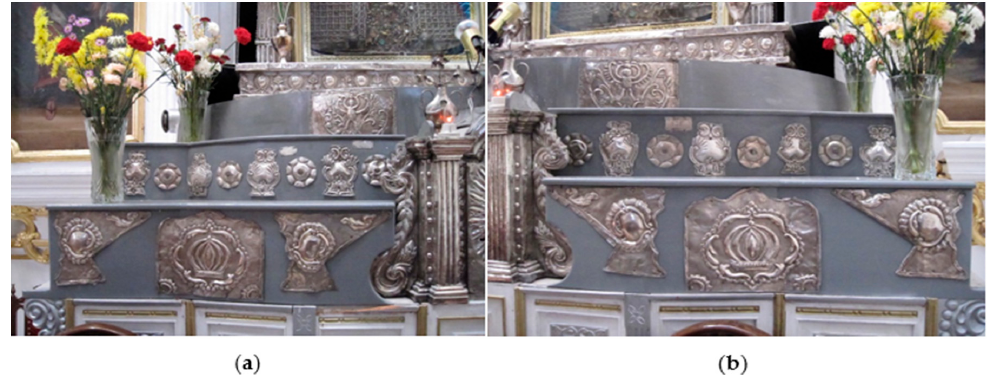
Figure 5. ( a , b ) Tabernacle and candle banks, altar in the chapel of the Virgin of Guadalupe, Sucre, Bolivia (photo: Andrea